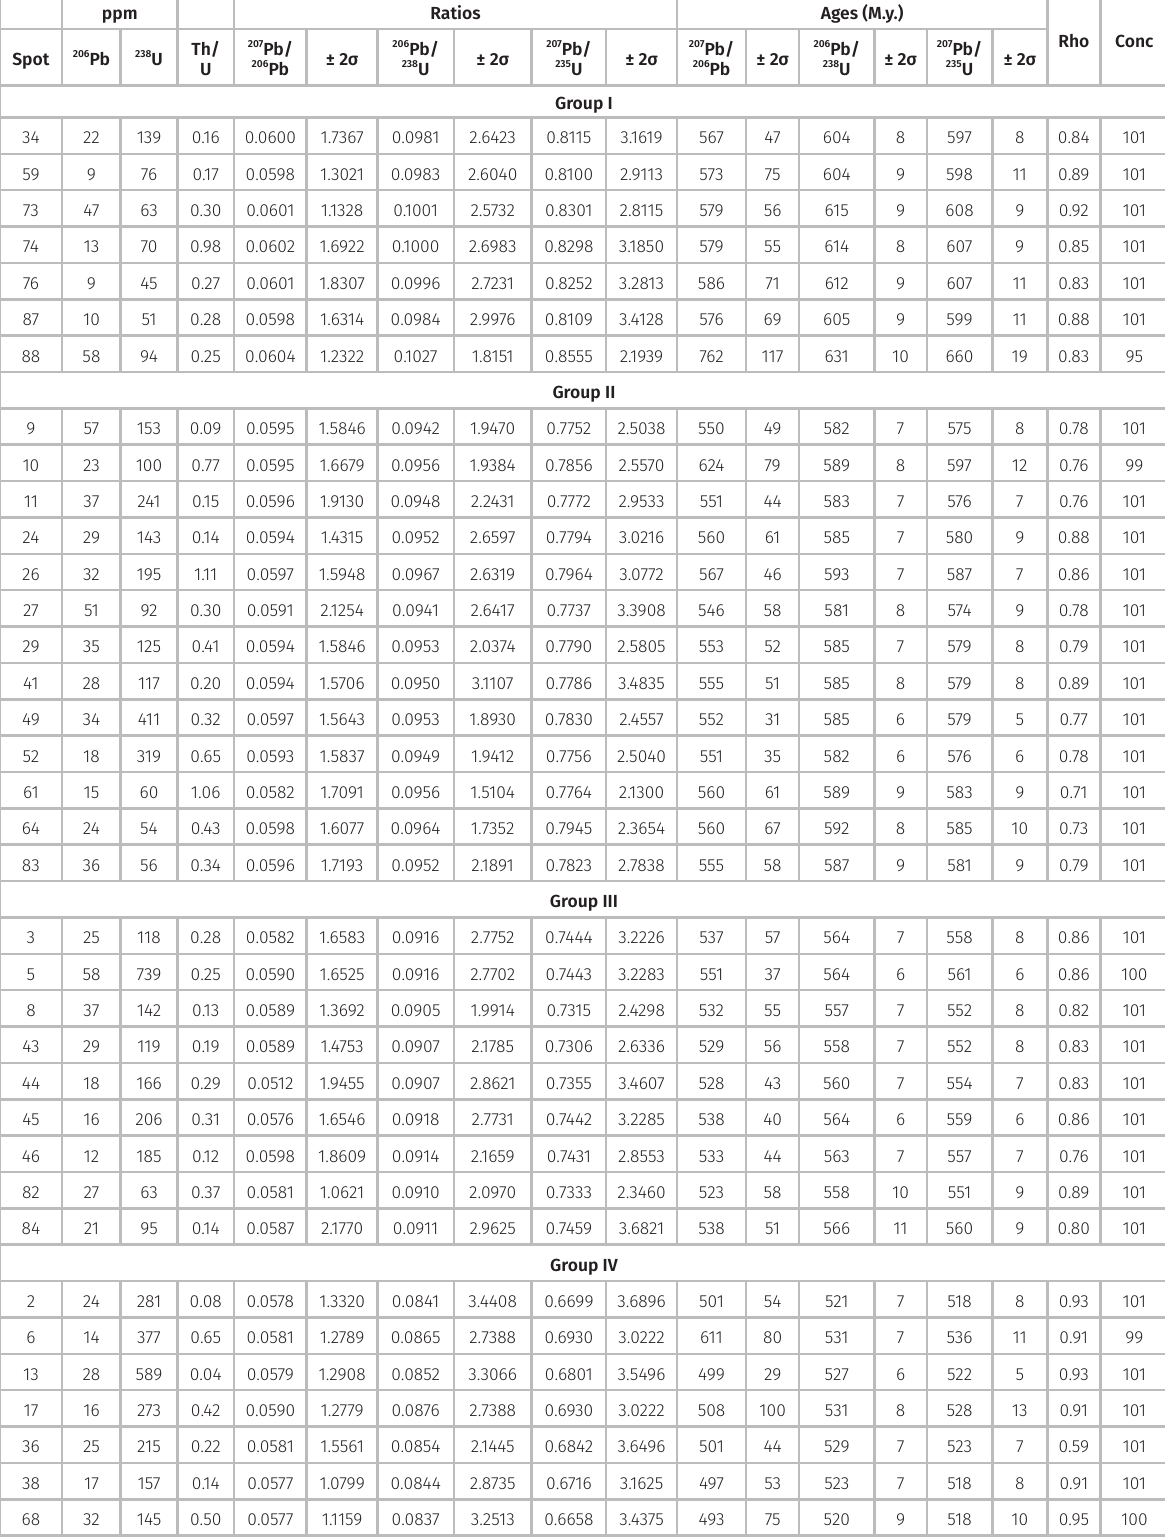
Table VIII. U-Pb data determined by